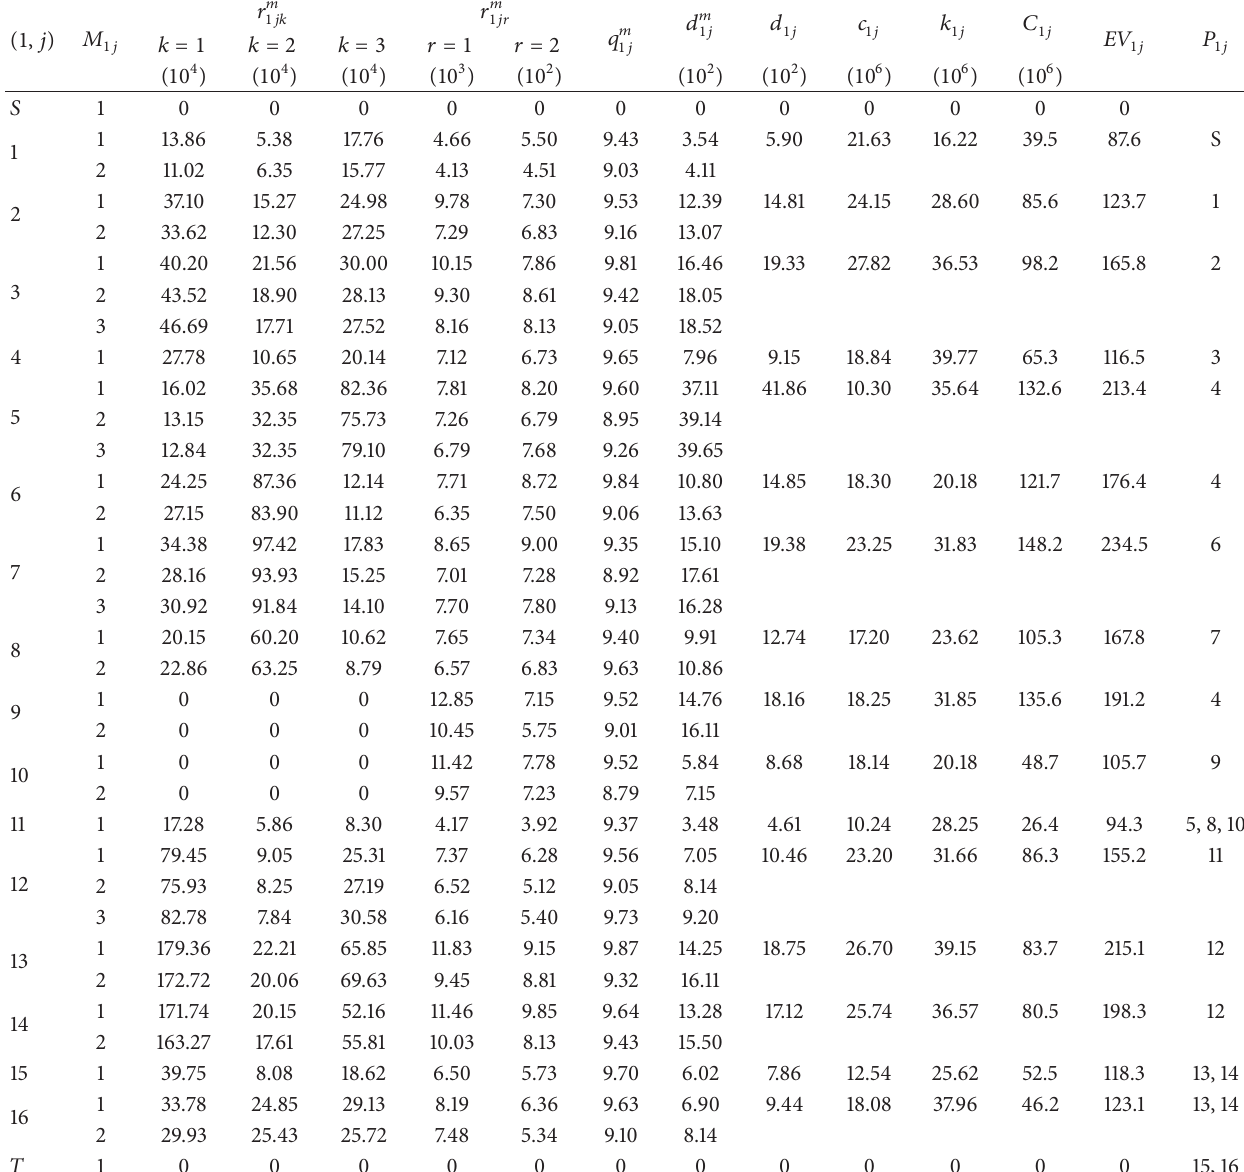
Table 2: Detailed information of each activity in the river diversion construction